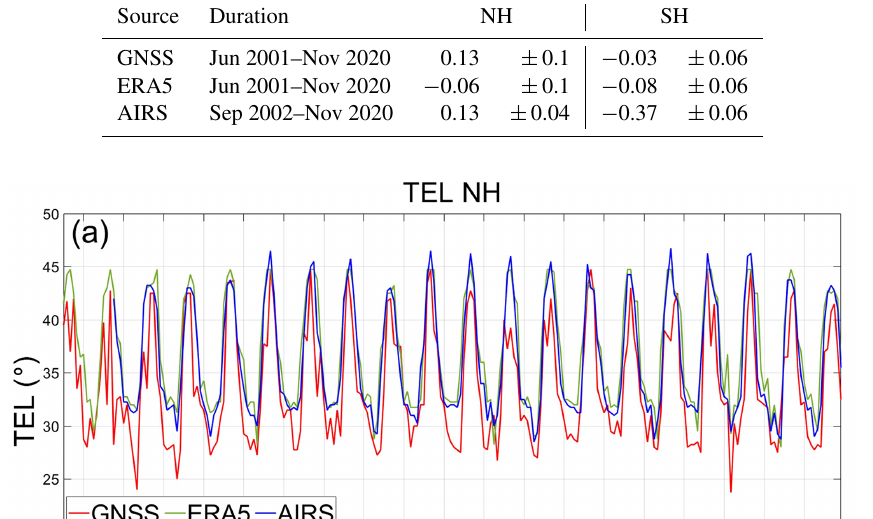
and a weak expansion or non-significant contraction in the